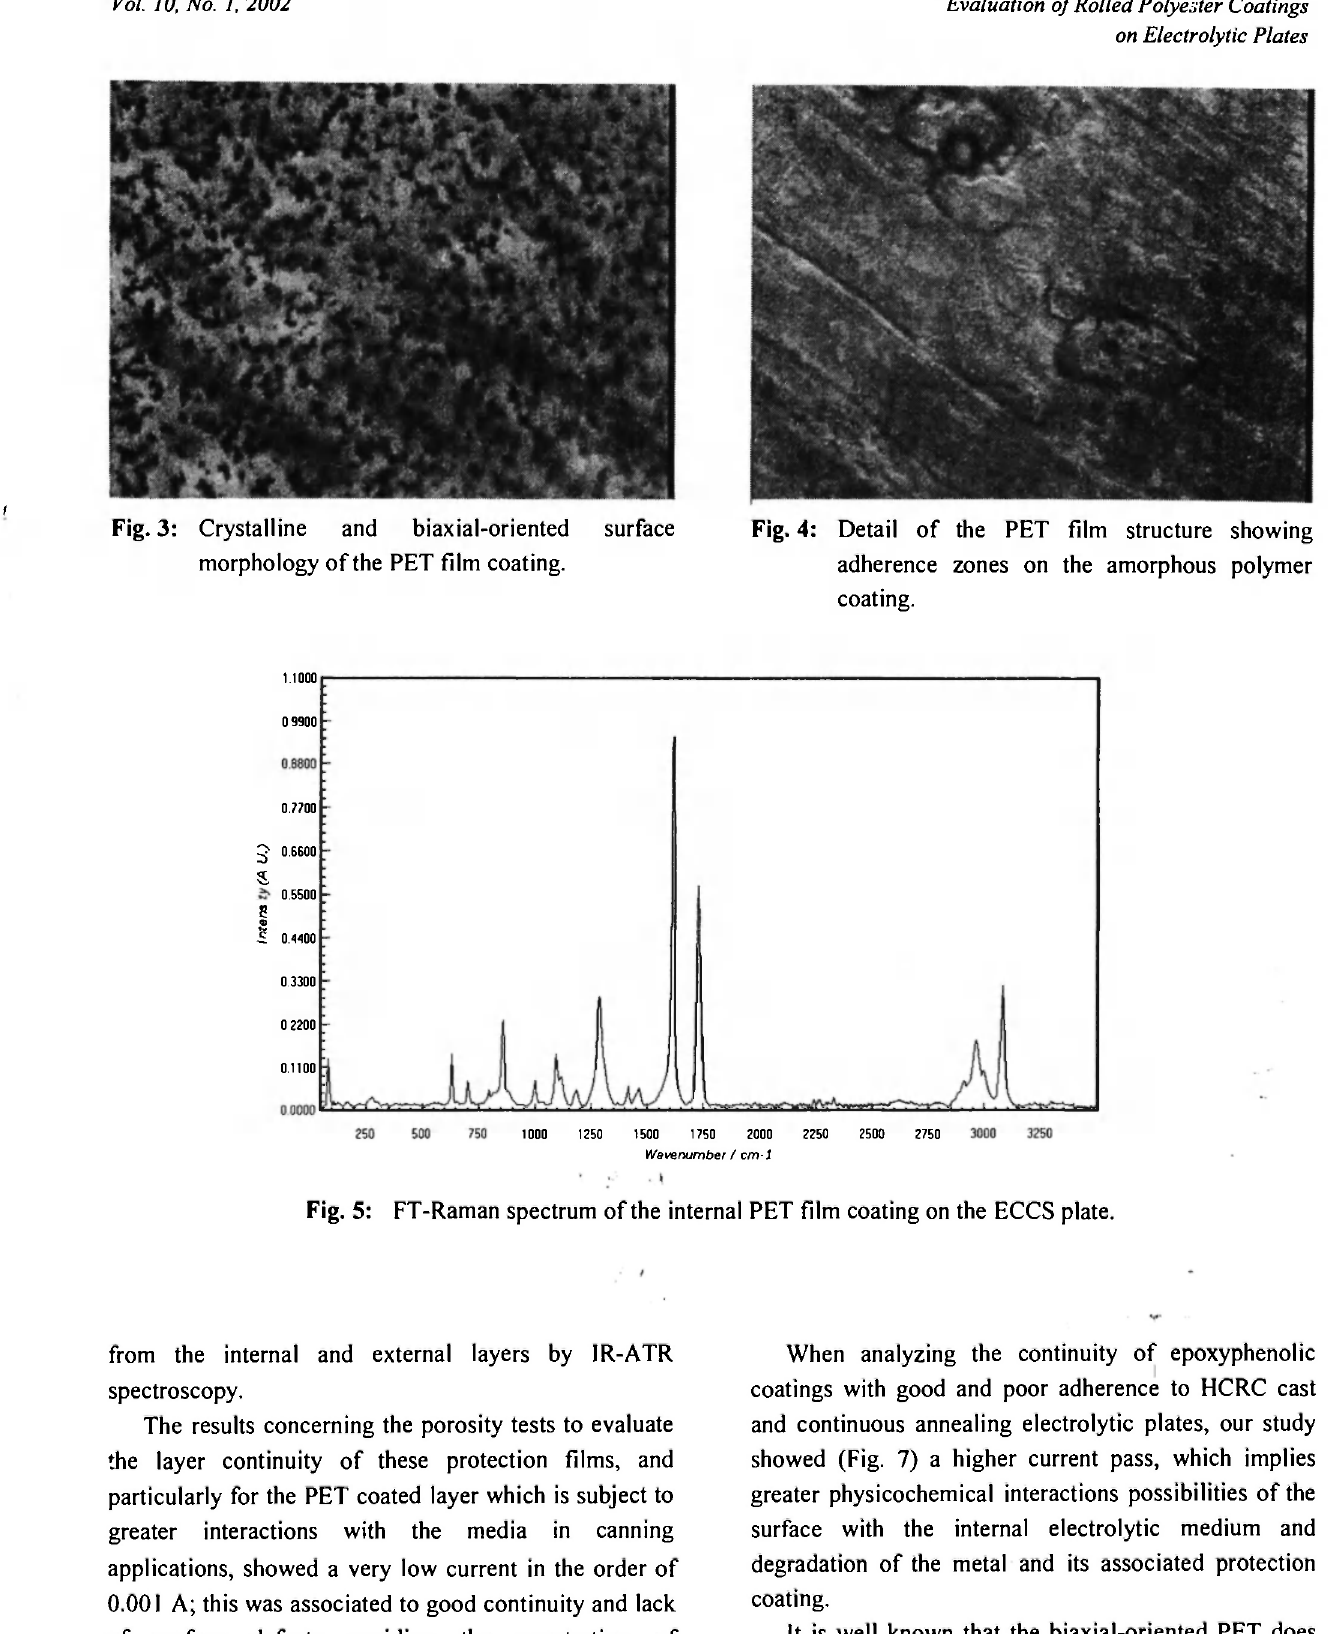
Fig. 5: FT-Raman spectrum of the internal PET film coating on the ECCS plate.